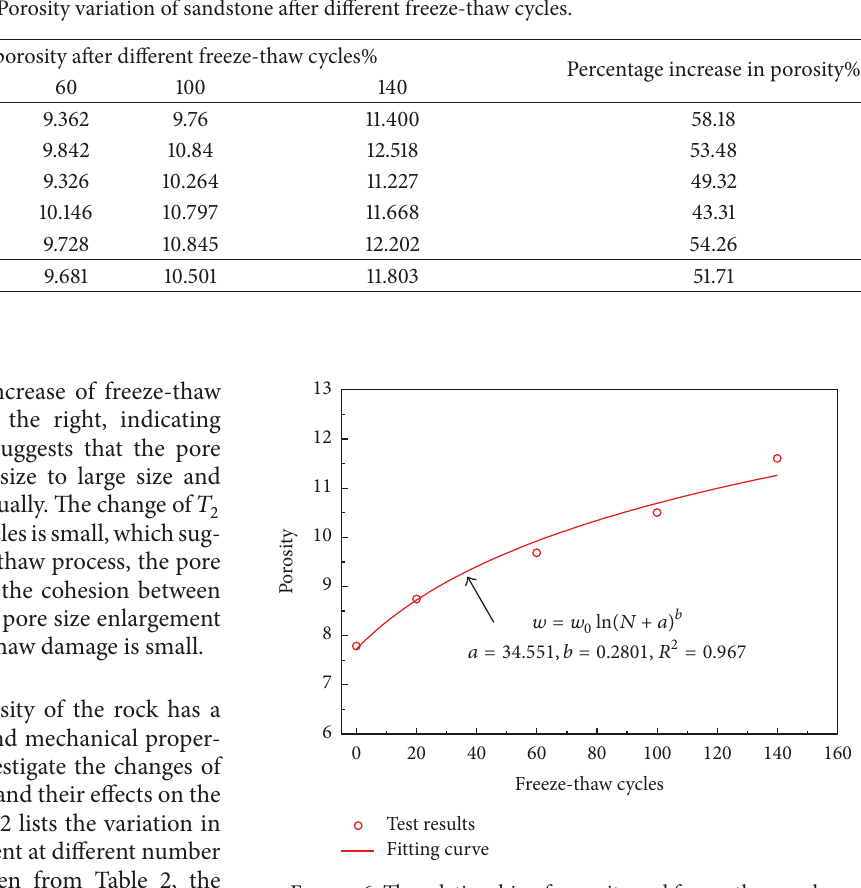
Figure 6: The relationship of porosity and freeze-thaw